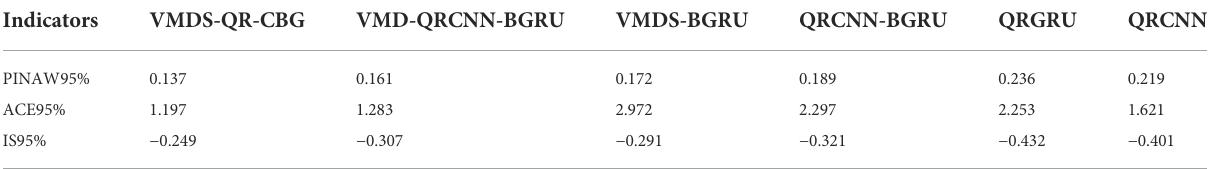
TABLE 4 Interval predication error statistics of different